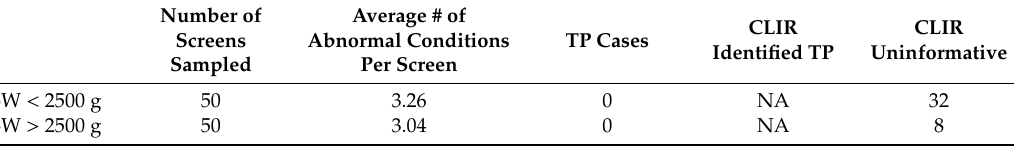
Table 3. Correlation and performance of CLIR tools with complex screens. NA = Not applicable; there were no TP cases identified in either